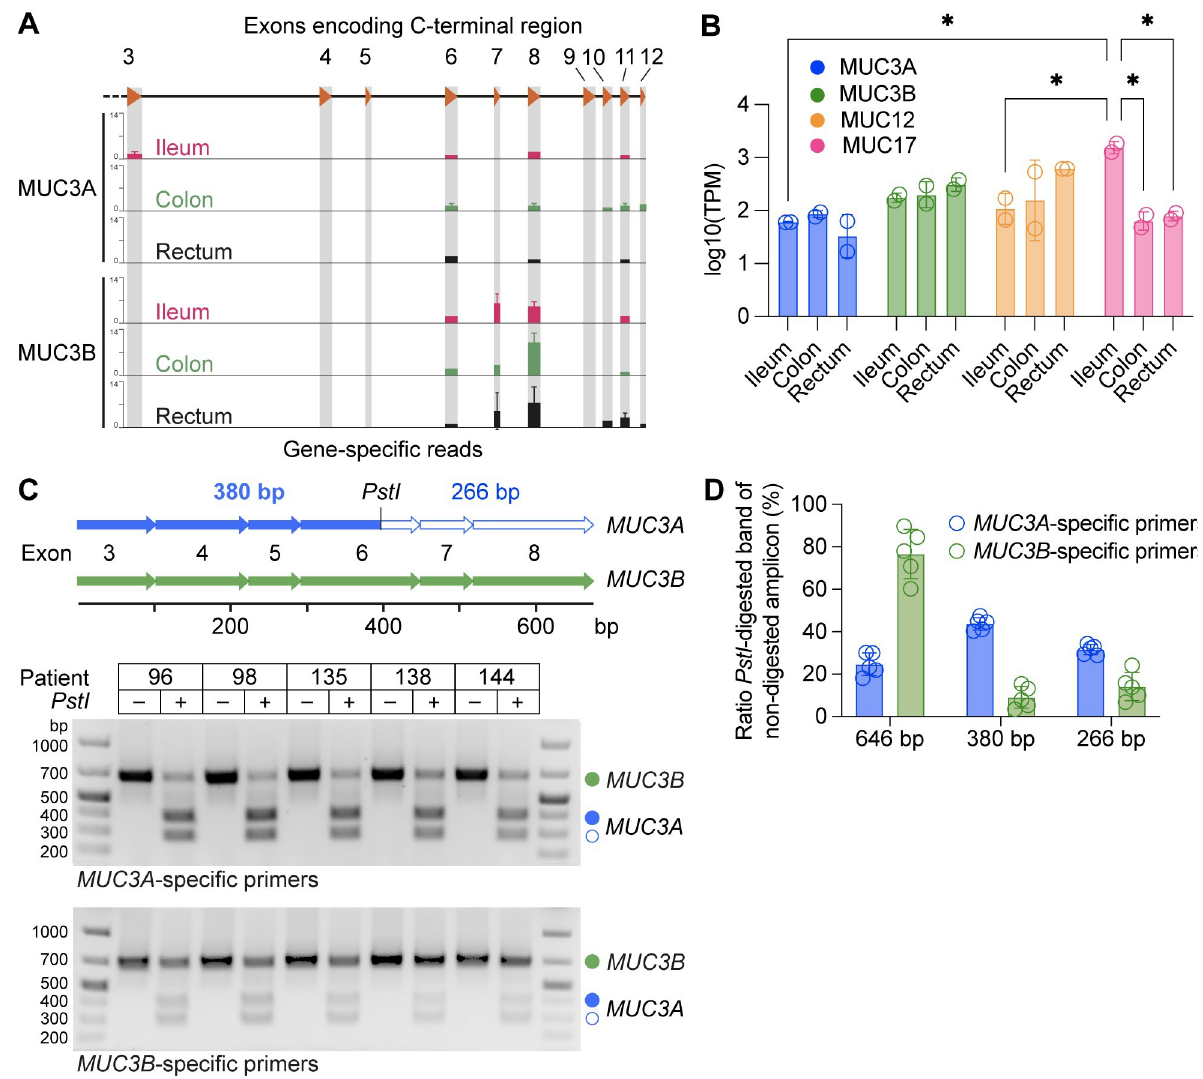
Fig 5. Expression of MUC3B gene in the human intestine. (A) Unique reads for MUC3A and MUC3B in RNA-sequencing data from human ileum, colon, and rectum mapped to T2T-CHM13 human genome assembly. (B) Gene expression of MUC3 cluster genes in human ileum, colon, and rectum. 2 samples per tissue segment. � p < 0.05 as determined by two-way ANOVA, corrected for multiple comparisons using Tukey´s test. Data are presented as mean ± standard deviation (SD). (C) Specific primers amplify a 646 bp cDNA spanning exons 3–8 in MUC3A and MUC3B transcripts from the ileum of five individuals. MUC3A cDNA carries a PstI restriction site in exon 6 that distinguishes MUC3A from MUC3B transcripts. Agarose gel electrophoresis of PstI restriction digests of amplified cDNA from MUC3A and MUC3B transcripts results in 380 bp and 266 bp fragments from MUC3A cDNA. (D) Quantification of bands from agarose gel in C. n = 5 individuals. Data are presented as mean ± standard deviation (SD).